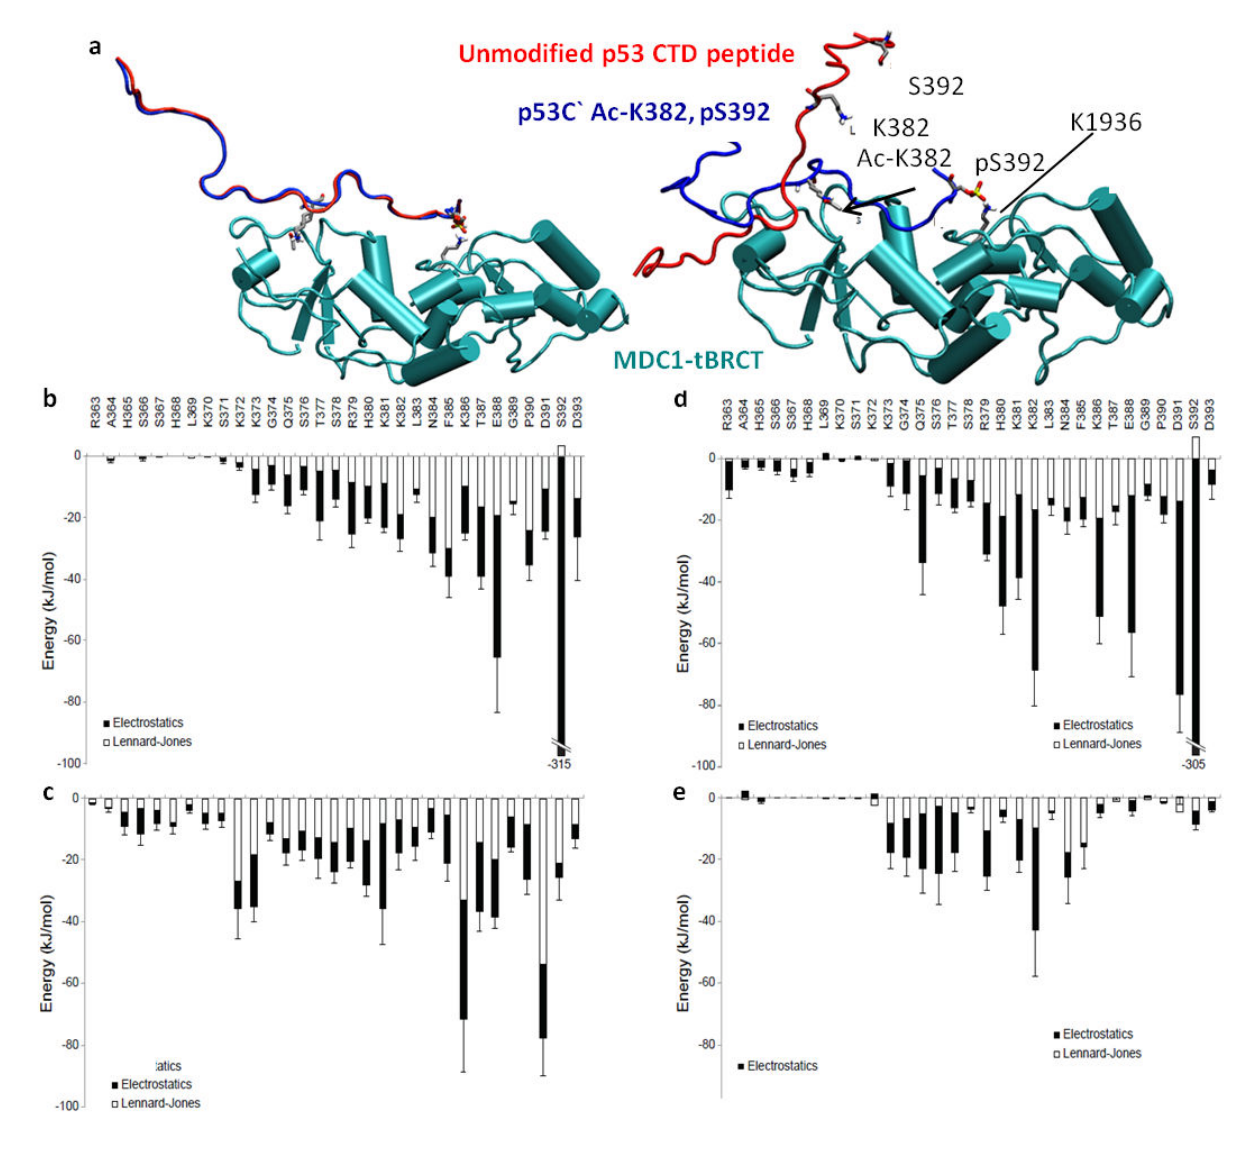
Figure 4. In p53 CTD, acetylation of K382, phosphorylation of S392 or both, contribute to the binding to MDC1-tBRCT. (a) Cartoon representations of the p53 CTD peptides (Acetylated and phosphorylated peptide in blue or unmodified peptide in red), MDC1-tBRCT in cyan and phosphorous atom in gold. Left - initial conformations; right - representative snapshots of the molecular dynamics simulations. (b-e) Potential energy of the interactions between p53 CTD peptides and MDC1-tBRCT; The Lennard-Jones and the electrostatic contributions of each residue are shown in white and black, respectively. The peptides: (b) Ac-K382 and pS392. (c) Ac-K382. (d) pS392. (e) Unmodified. Error bars represent the standard deviation of the mean for the sum of the interactions. doi: